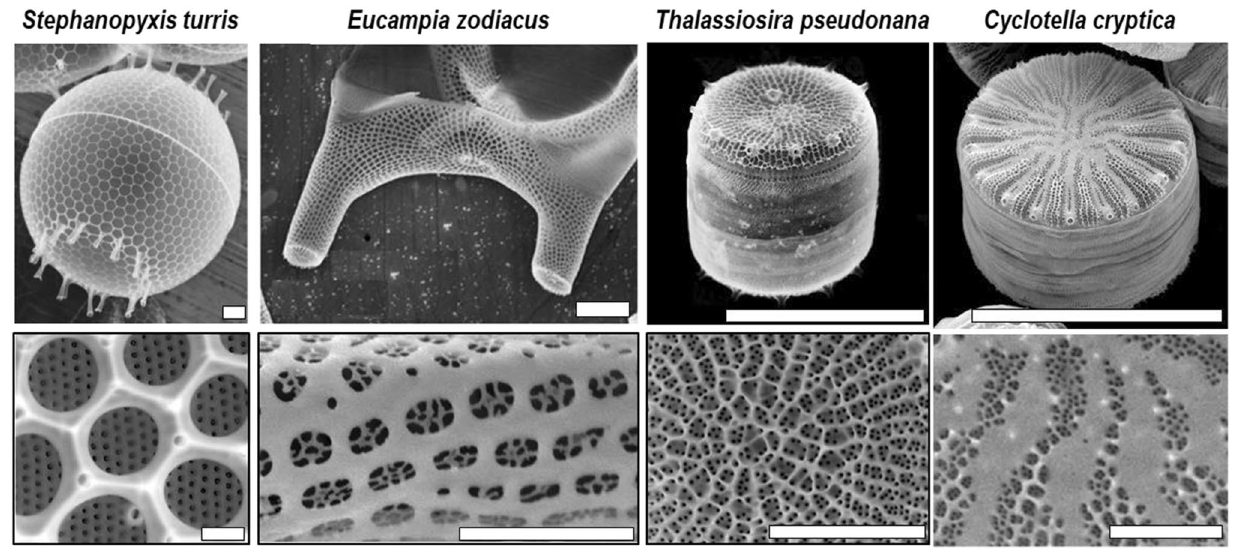
Fig. 2 Scanning electron microscopy images of overviews (top) and corresponding details (bottom) of the biosilica from individual cells of different diatom species. Scale bars: 5 µm (top), 1 µm